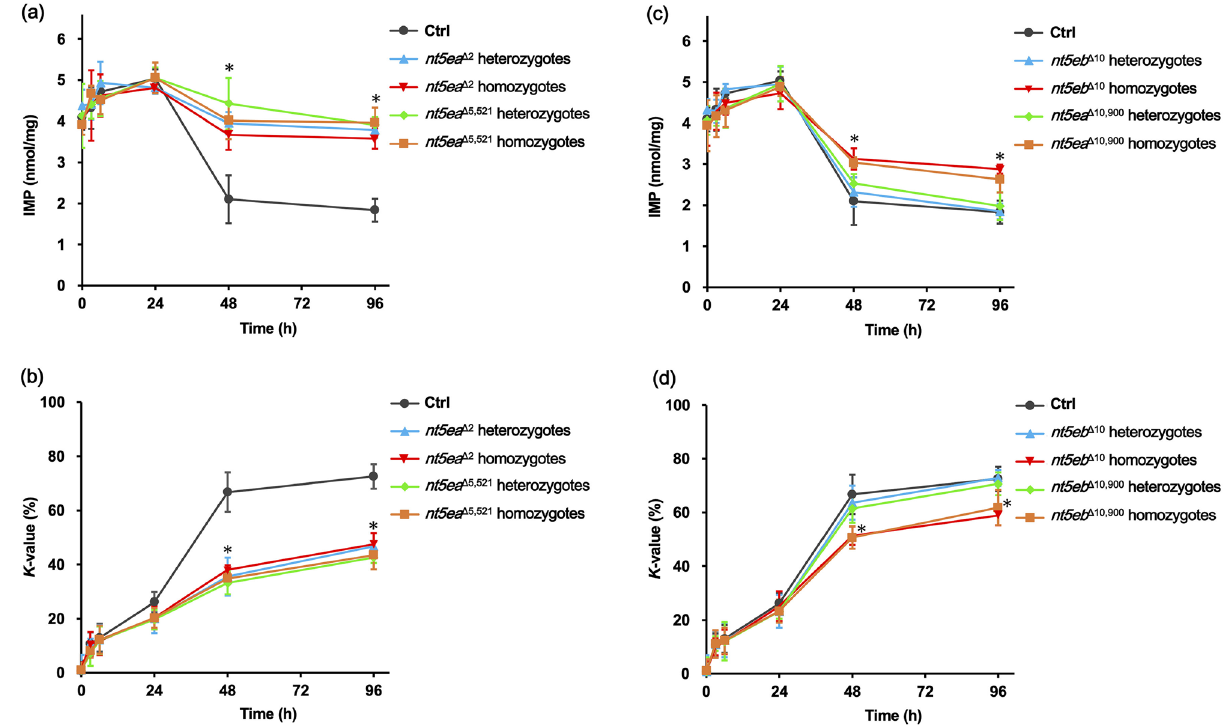
Figure 4. Chemical evaluation of fish meat stored in refrigeration. ( a , b ) Inosine monophosphate (IMP) contents and K -values of wild-type and nt5ea mutant fish from 0 to 96 h postmortem. Data are presented as the mean ± SD (n = 4/group at 0, 3, 6, and 24 h and n = 7/group at 48 and 96 h). Wild-type fish harboring no mutation were used as a control (Ctrl). The asterisks indicate that the values of each mutant group, nt5ea +/∆2 , nt5ea ∆2/∆2 , nt5ea +/∆5,521 , nt5ea ∆5,521/∆5,521 , were significantly different compared to those of the Ctrl group according to one-way ANOVA followed by Tukey’s HSD test, * P < 0.05. ( c , d ) IMP contents and K -values of wild- type and nt5eb mutant fish from 0 to 96 h postmortem. Data are presented as the mean ± SD (n = 4/group at 0, 3, 6, and 24 h and n = 7/group at 48 and 96 h). Wild-type fish harboring no mutation were used as a control (Ctrl). The asterisks indicate that the values of each homozygous mutant group, nt5eb ∆10/∆10 or nt5eb ∆10,900/∆10,900 , were significantly different compared to those of the Ctrl group according to one-way ANOVA followed by Tukey’s HSD test. * P <